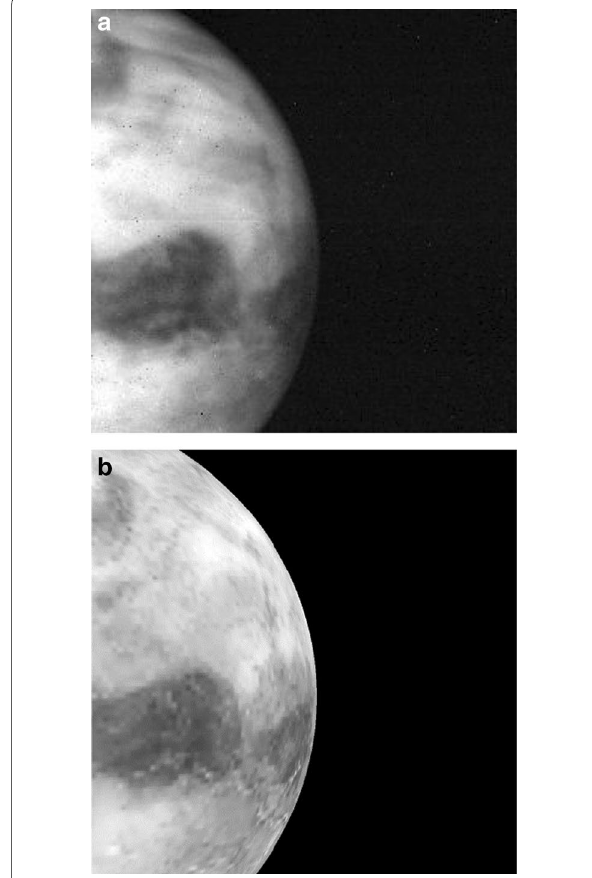
Fig. 17 a A 1.01‑μm nightside Level 2 image at 00:38 on January 21, 2016, at a distance of 44,000 km with a sub‑spacecraft latitude of 3°, a longitude of 67° and a phase angle of 147°. b A preliminary + 1.01‑μm thermal radiance simulation intends to reproduce a based on the Magellan topographic information (Ford and Pettengill 1992) and VIRA 1985 (Seiff et al. 1985) temperature with uniform emissivity and 100‑km smearing assumed without limb darkening